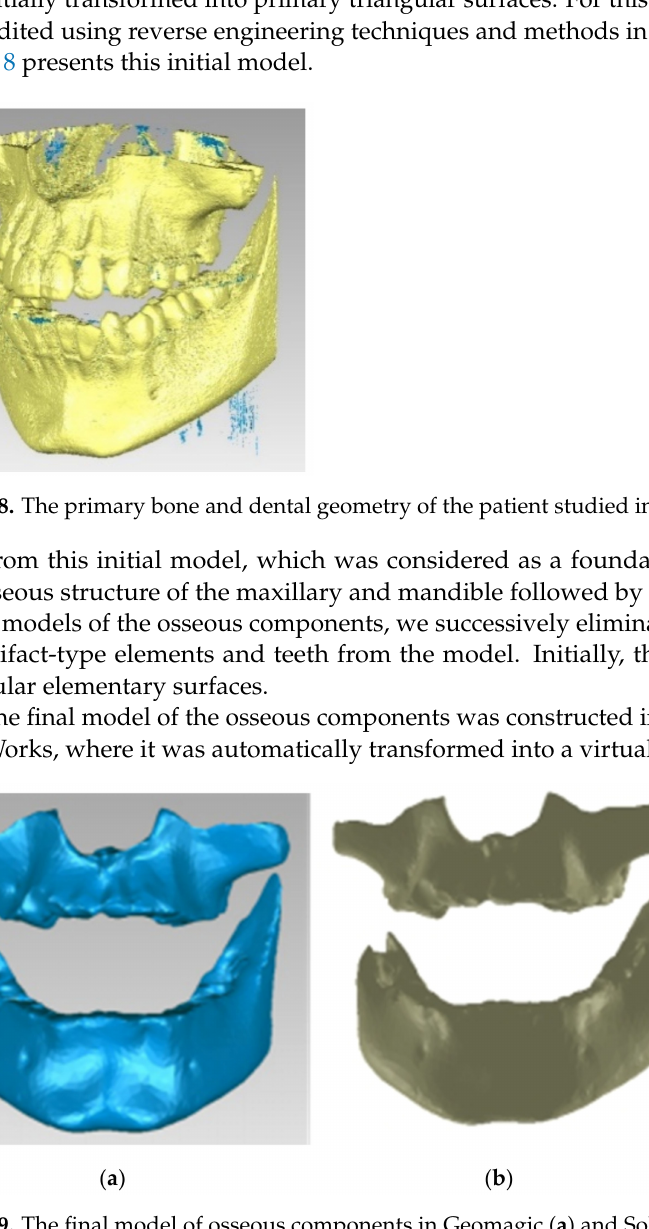
Figure 9. The final model of osseous components in Geomagic ( a ) and SolidWorks ( b